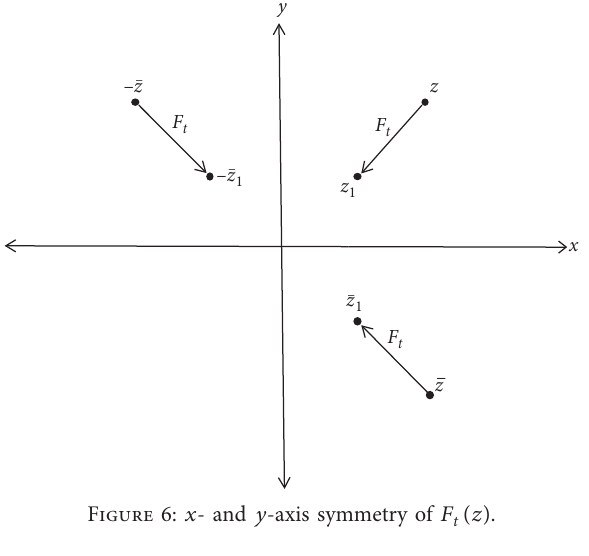
( z ) in quadrant I. F 0